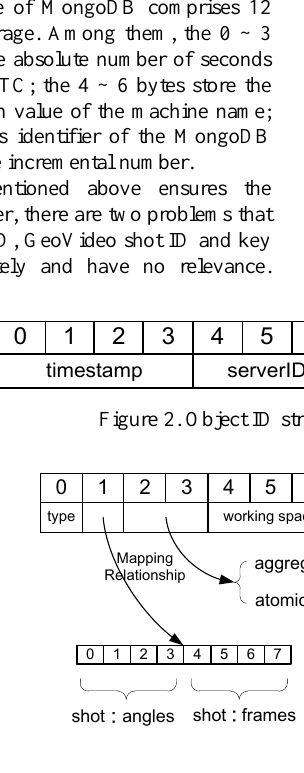
Figure 3. Multi-layer ID